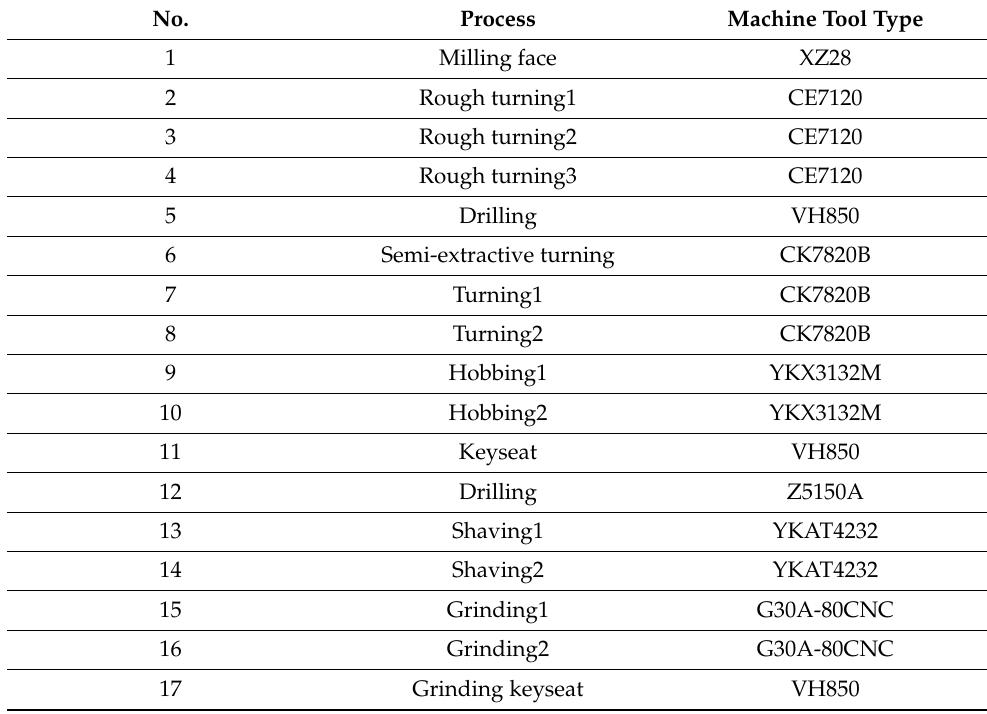
Table 2. Processing information.